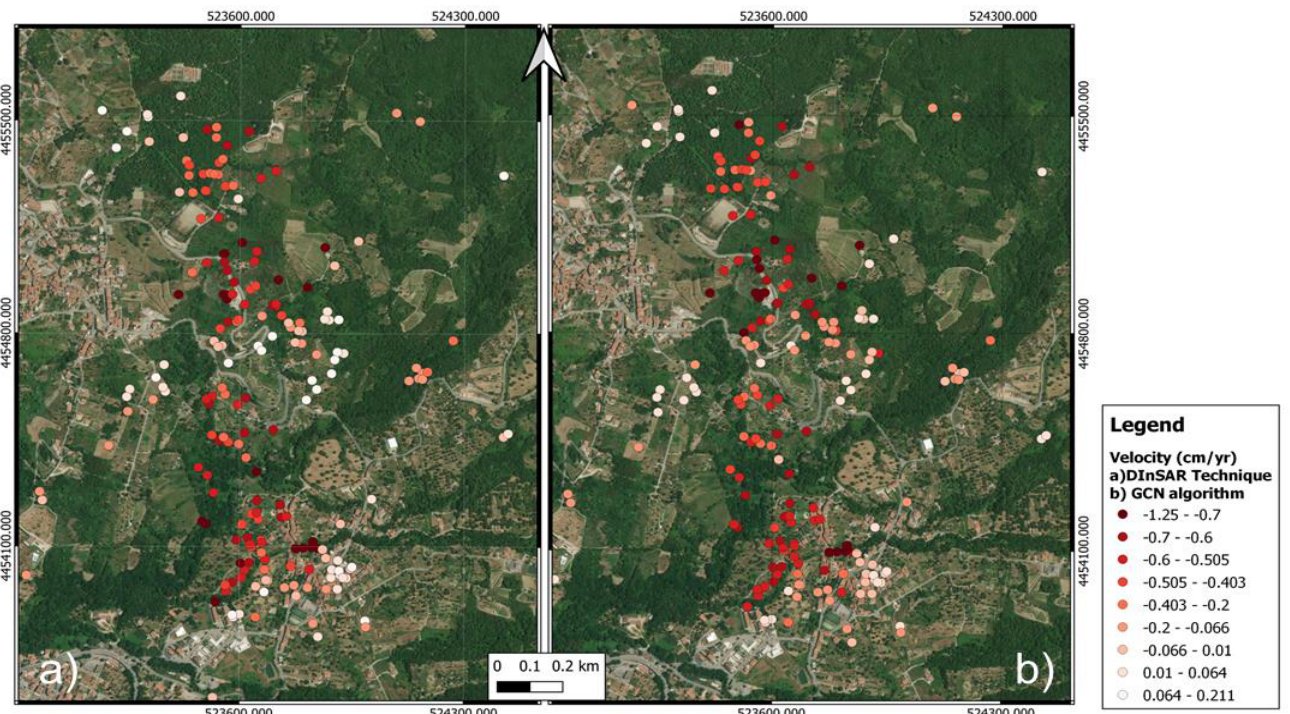
Figure 3 . Location and map of displacement by a) DInSAR technique and b) GCN (Unit: